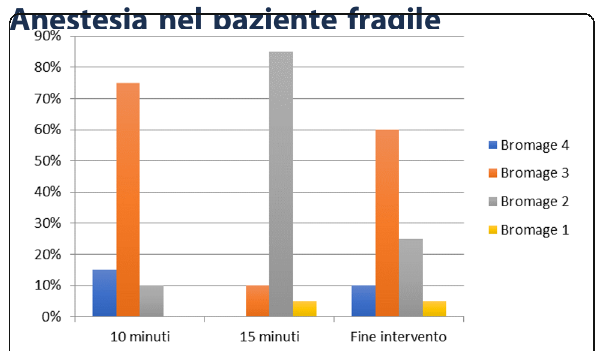
Fig. 2 (abstract A52). Motor Block onset and